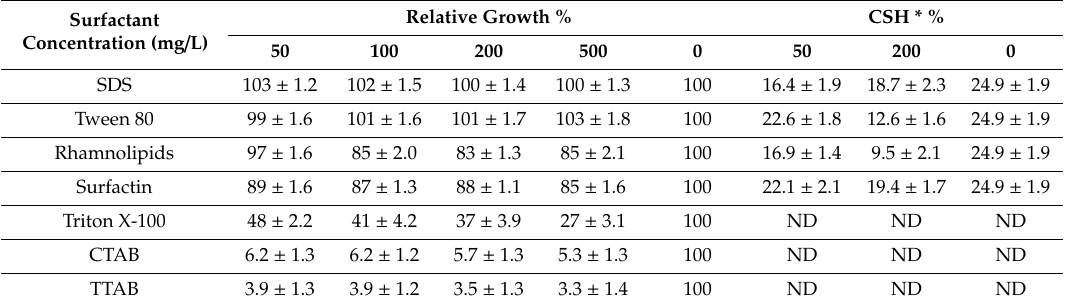
Table 2. The e ff ect of surfactants at various concentrations on the growth and CSH of strain BL-27. Surfactant Concentration (mg / L)